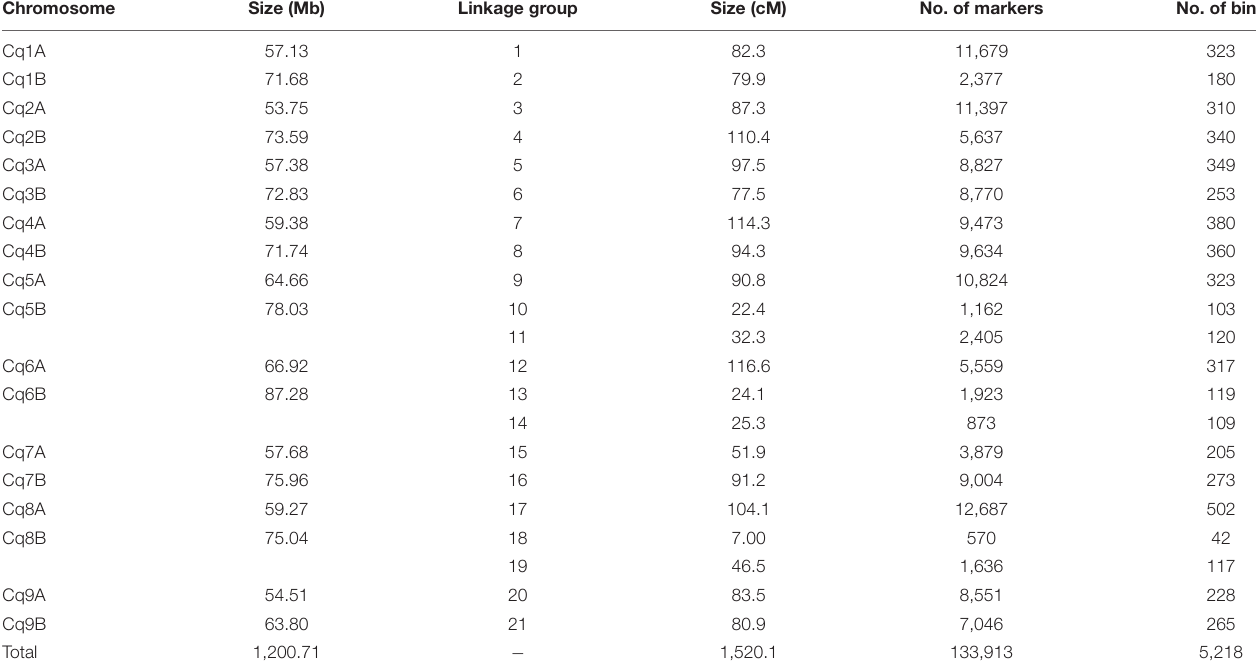
TABLE 3 | Summary statistics of the quinoa linkage map based on F 2 plants derived from a cross between CHEN-109 and PI-614889. Chromosome Size (Mb) Linkage group Size (cM) No. of markers No. of